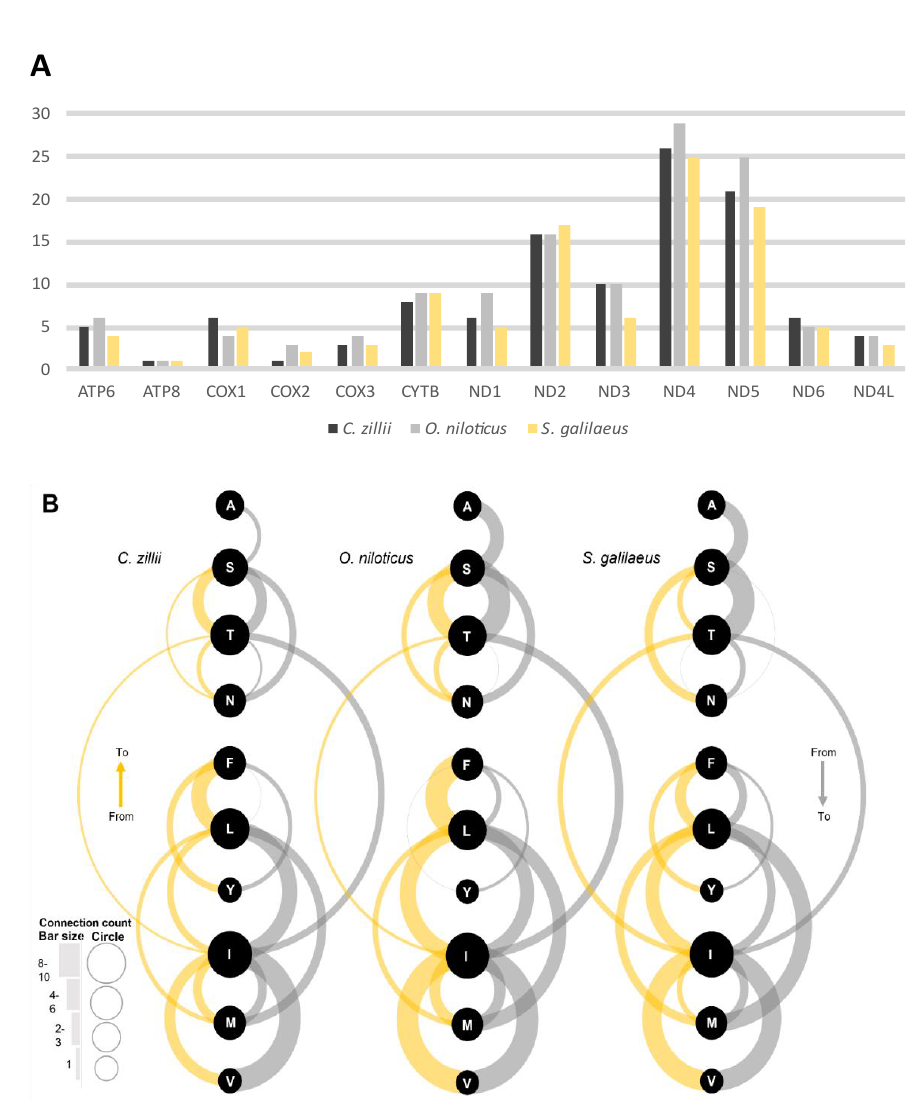
Figure 3. ( A ) Amino acid changes between the Nile tilapiine mitogenomes for the protein-coding genes. ( B ) The arc diagram displays the changes in amino acids among the Nile tilapiine species. Each change represents by a black circle and connects with arcs. The gray arcs visualize forward mutations, and the gold arcs visualize reverse mutations. Arc thickness and circle size represent the number of changes for these amino acids. The amino acids are described with a one-letter abbreviation.